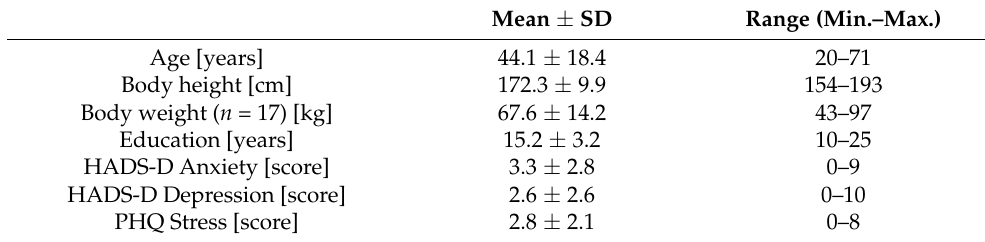
Table 3. Demographic information of all participants ( n = 25). Education included school years plus years up to the highest graduation achieved (e.g., German Abitur equals 12 years of education). The HADS-D anxiety score had a cut-off value of >10 and the HADS-D depression score had a cut-off value of >8. The PHQ stress score had a maximum of 20 points.